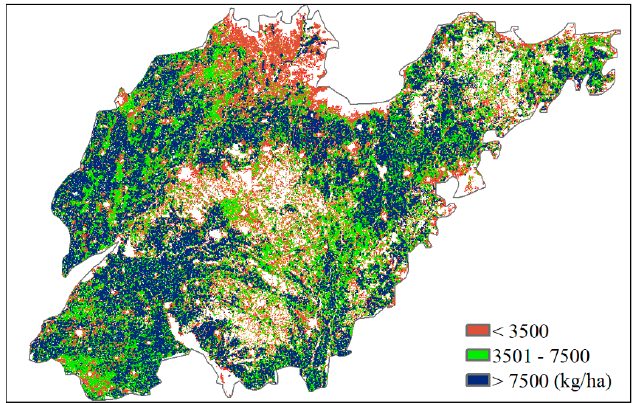
Figure 6. Potential yield of Shandong Province simulated by the GAEZ model.